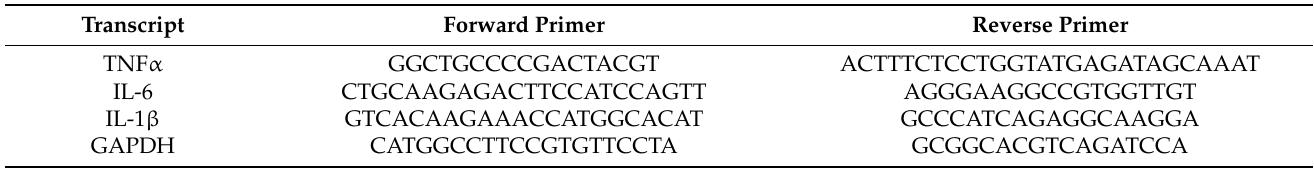
Table 1. qRT-PCR primer sequences (5 (cid:48) to 3 (cid:48)